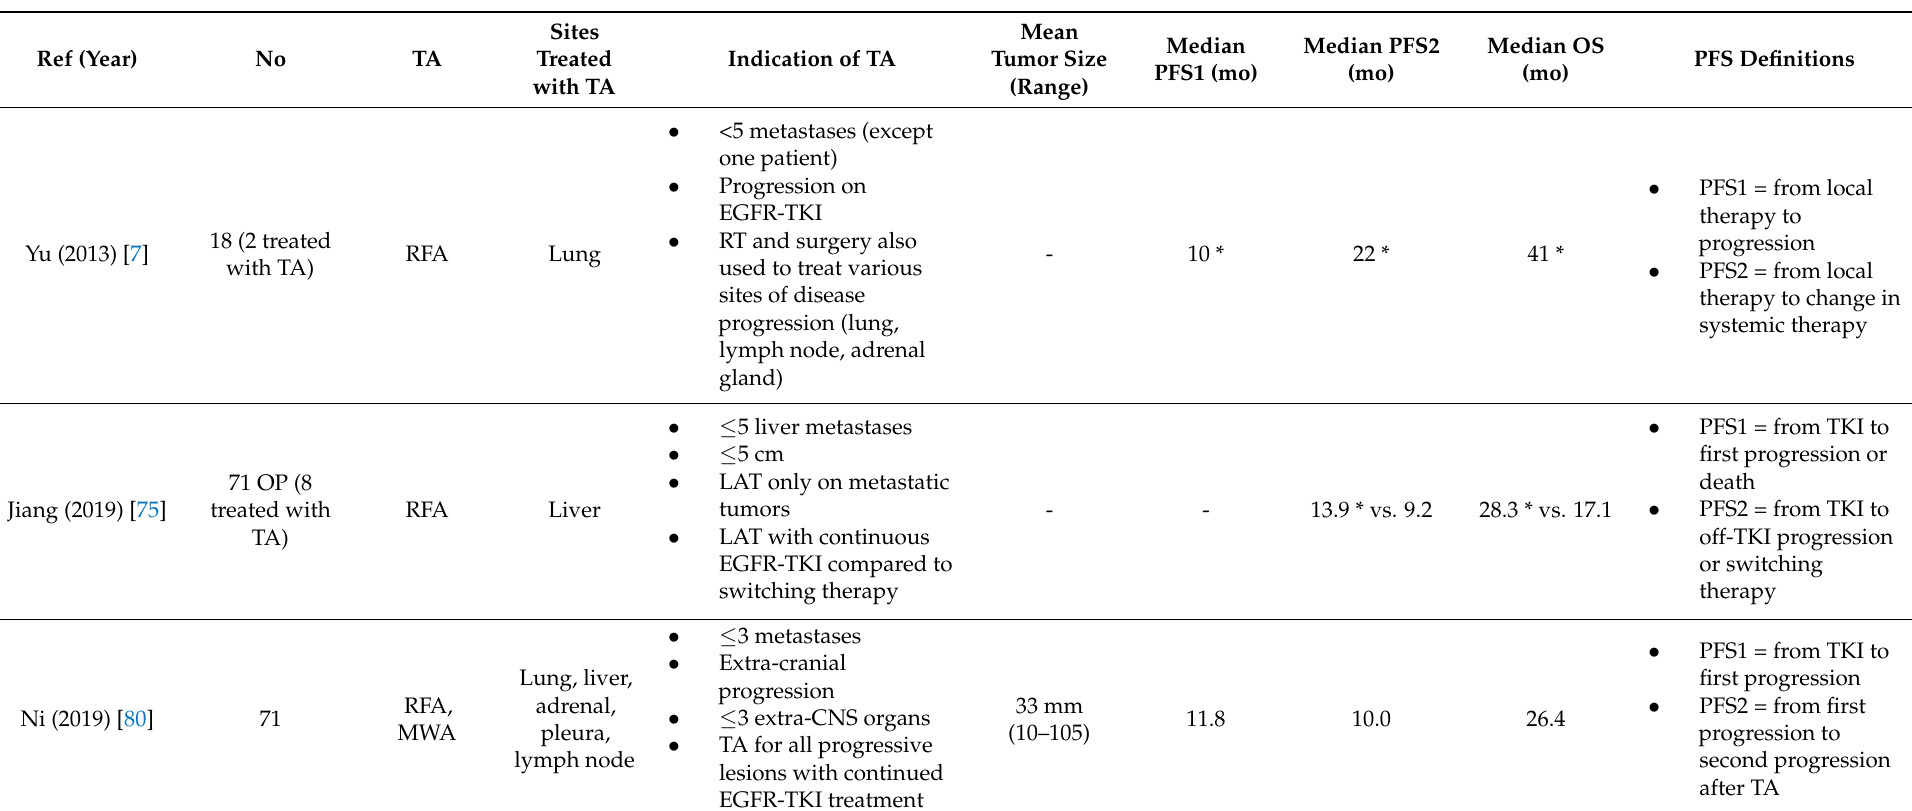
Table 3. Selected studies evaluating thermal ablation for oligoprogressive NSCLC